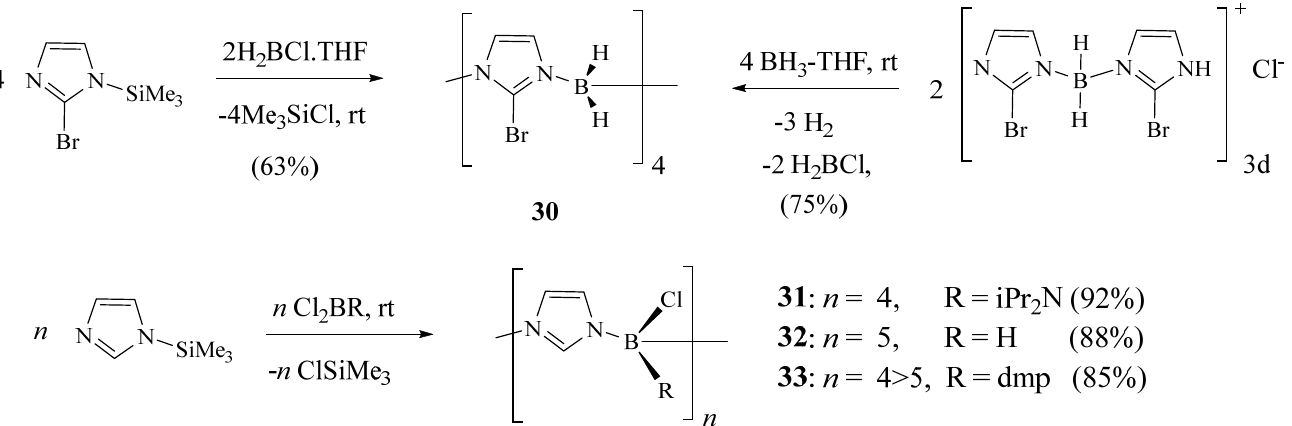
Figure 8. Imidazolic macrocycle 29 and its silver complex. (Reprinted with permission from ref. [23]. Copyright 2019 Royal Society of Chemistry).